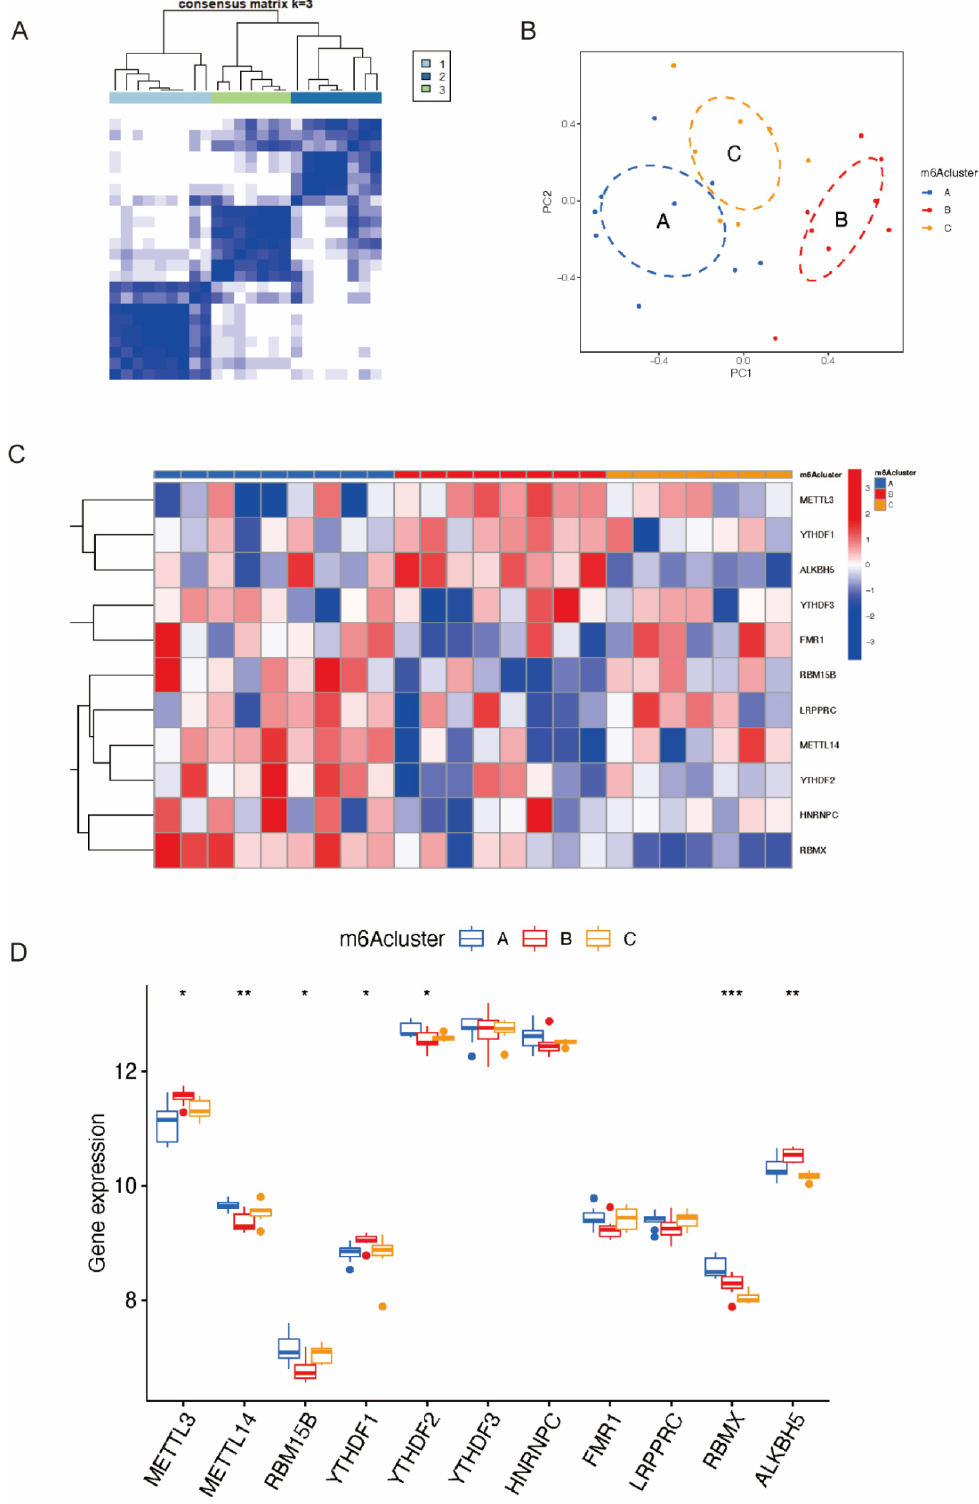
Figure 6. Identification of three distinct m6A patterns. ( A ) Three distinct m6A patterns based on significant genes. ( B ) Principal component analysis. ( C ) Expression heatmap of 11 candidate genes in three subtypes. ( D ) Differential expression histogram of 11 significant genes in three subtypes. *: p < 0.05, **: p < 0.01, ***: p < 0.001, NS: Non ‐ significance.